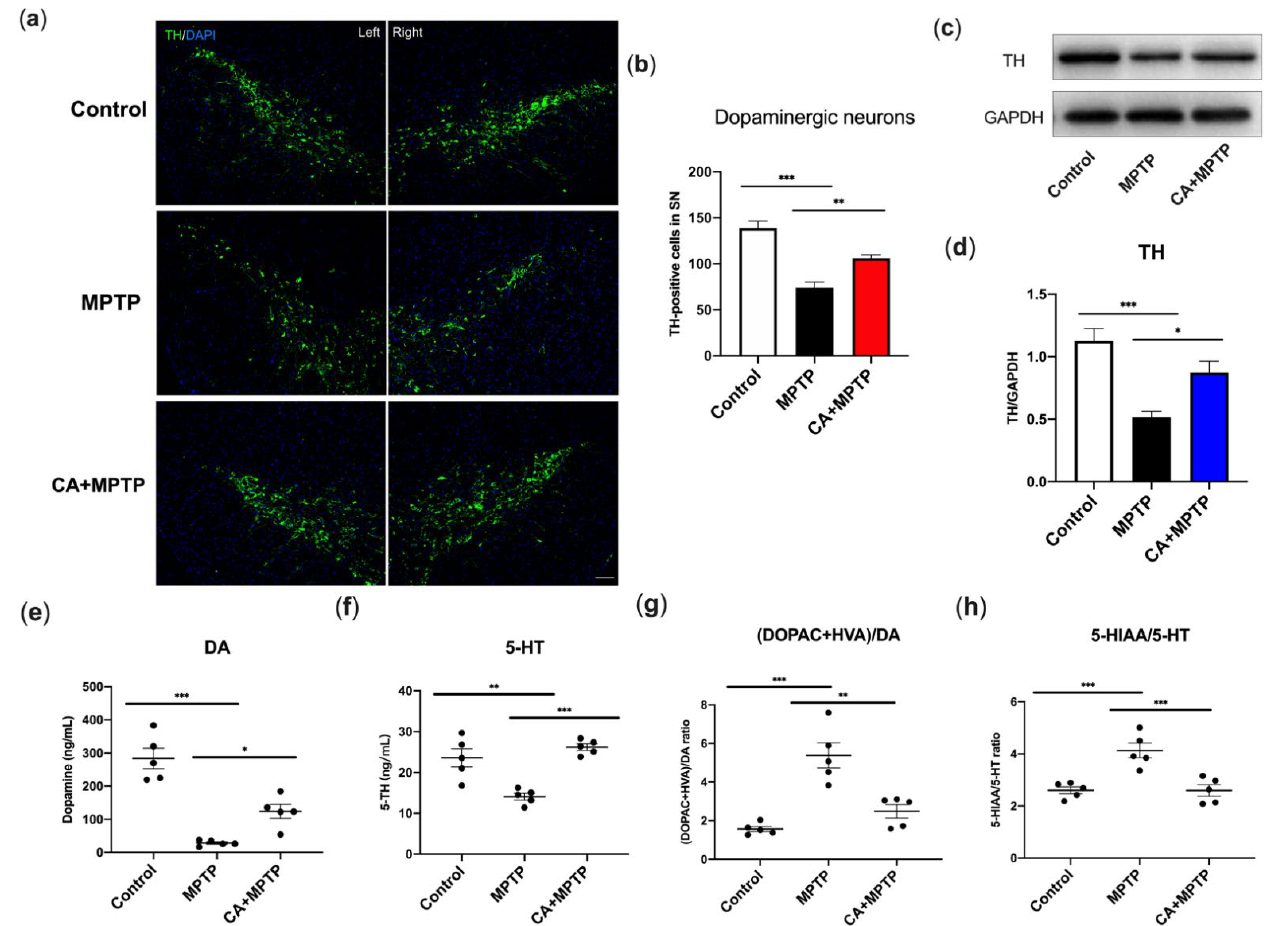
Figure 2. CA promoted the dopaminergic neuron survival, TH expression in striatum and the enhancement in neurotransmitters. ( a ) Representative IF staining for TH in the right and left SN, respectively. Scale bar: 100 µm. ( b ) Quantification for the number of TH-positive cells in left SN. ( c ) Representative bands of Western blotting for striatal TH expression. ( d ) Quantification for striatal TH expression, band intensity normalized to GAPDH. ( e ) The level of striatal DA. ( f ) The level of 5-TH. ( g ) The turnover rate of striatal DA ([DOPAC+HVA]/DA). ( h ) The turnover rate of striatal 5-HT (5-HIAA/5-HT). Statistical comparison by one-way ANOVA with Tukey’s post hoc test. Data represent means ± SEM. * p < 0.05, ** p < 0.01, *** p < 0.001. n = 4 for IF, n = 5 for the measurement of neurotransmitter and Western blotting.